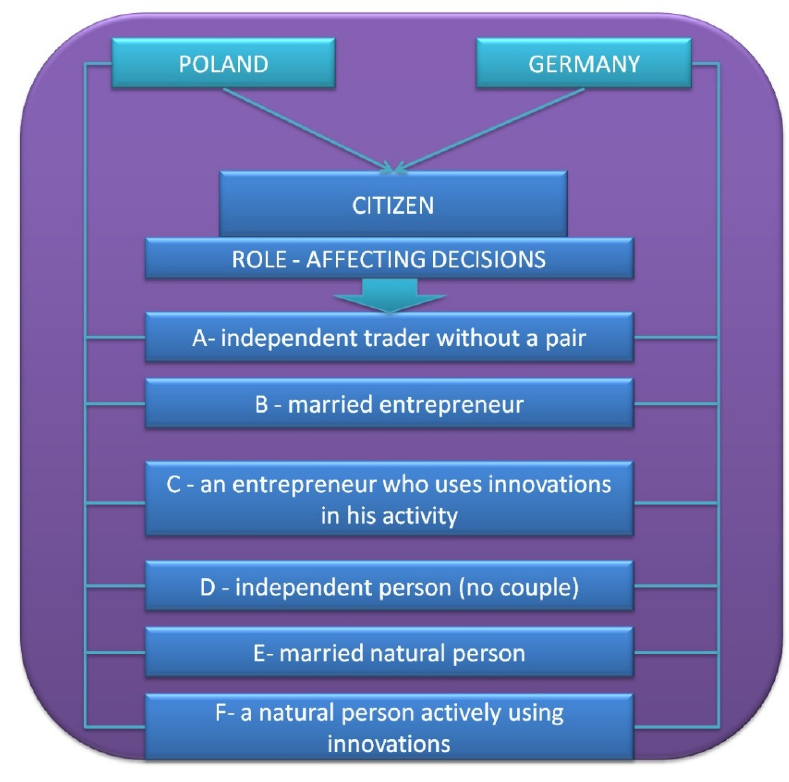
Figure 18. Possible assumed roles of a citizen.